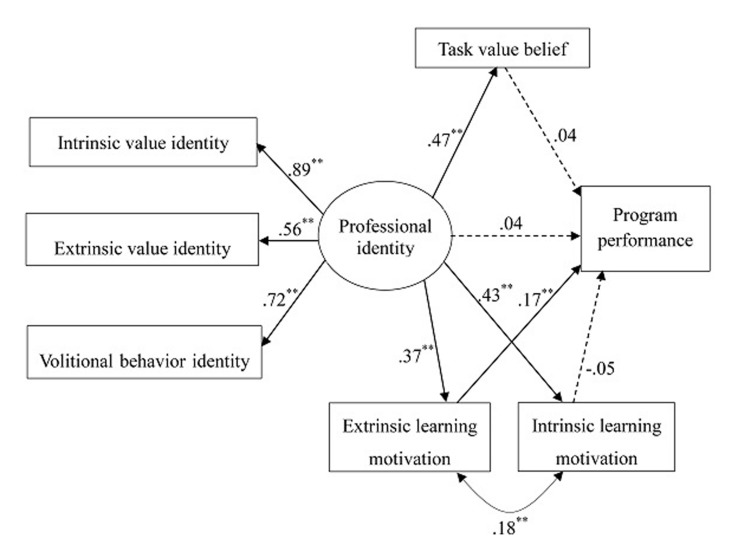
Independent Model (Model 2). Model fit: χ2(10) = 172.71, p < 0.001, CFI = 0.84, RMSEA = 0.16, 90% CI = 0.14 -0.19, SRMR = 0.07. ∗∗p ≤ 0.01.